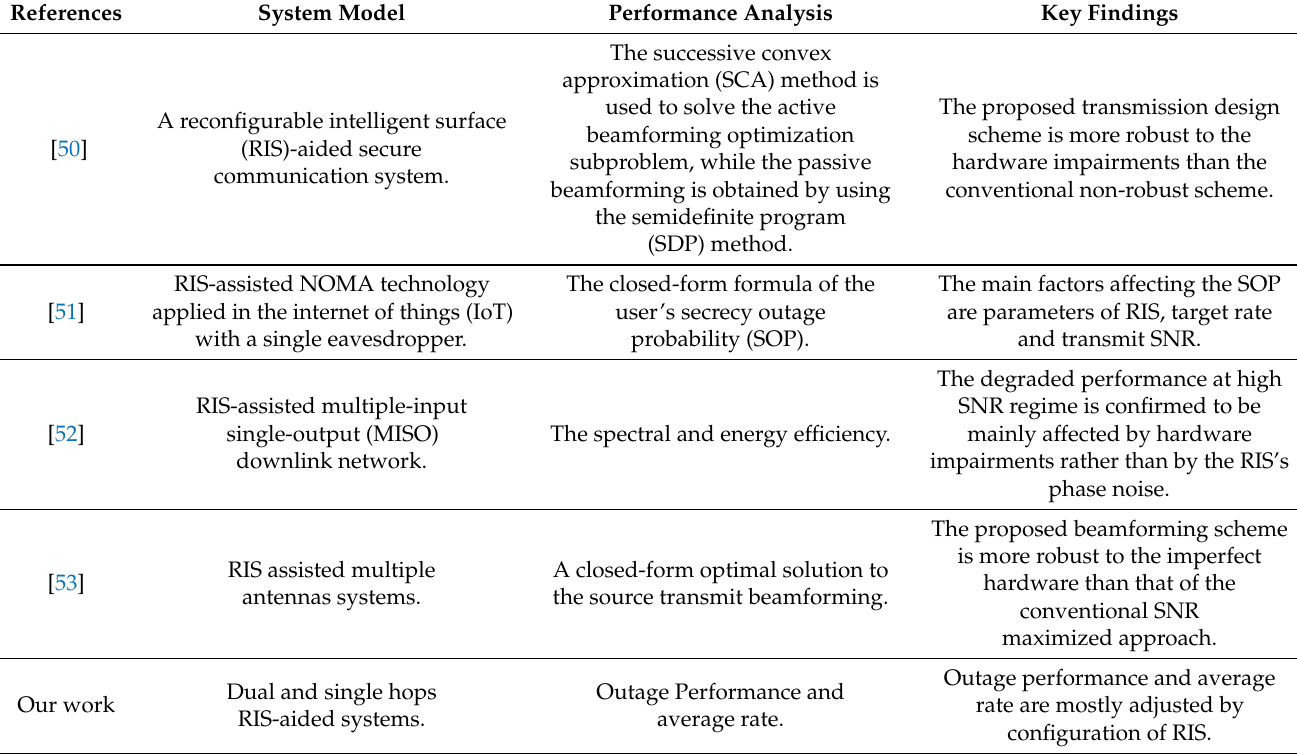
Table 1. Comparison of related works with current